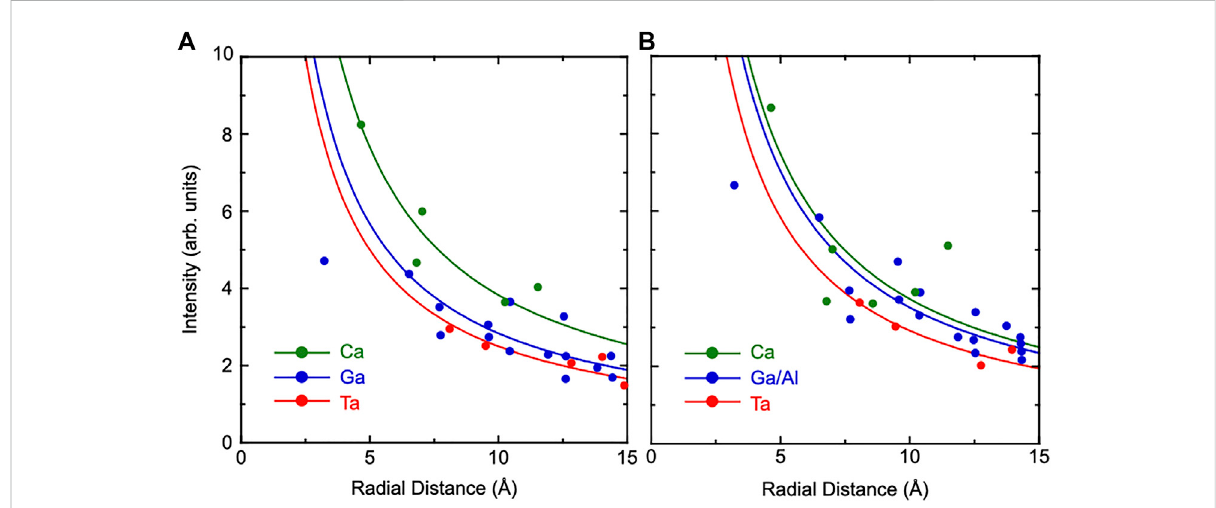
FIGURE 7 ImageintensitiesplottedasafunctionoftheradialdistancefromtheTaatomtoscatteredatomsinCTGS (A) andCTGAS (B) crystals.Green,red, andbluecirclesindicateimageintensitiesforCa,Ta,andGa(Ga/Al)atoms,respectively.Solidlinesarethe fi tofimageintensitieswiththeformula a / r , where r istheradialdistance fromtheTaatomand a isanadjusting